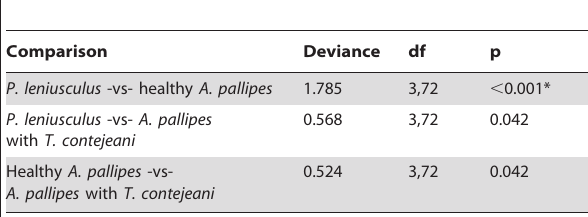
Table 4. Pairwise generalised linear model comparisons between crayfish groups in prey choice for non-mobile food items.